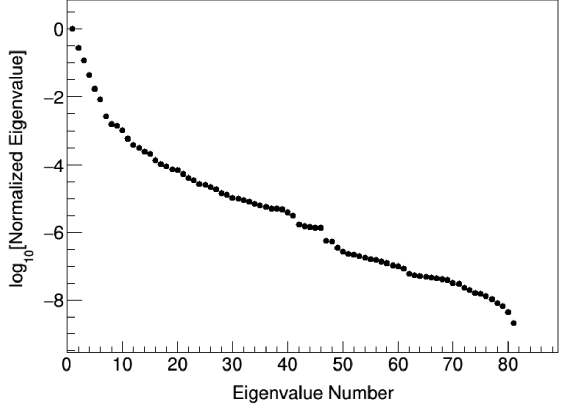
FIG. 1. The spectrum of eigenvalues obtained from the Hessian matrix of the emittance, normalized so that the first eigenvalue is equal to one. Note the logarithmic vertical scale. The Hessian matrix and its spectrum are available as Supplementary Material [27].